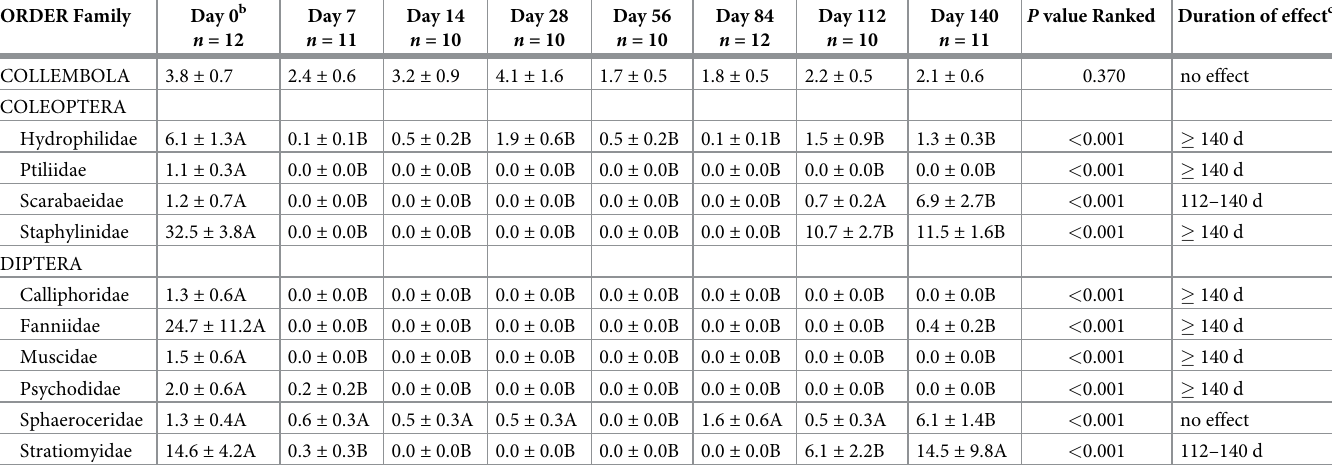
Table 1. Number of insects in each family and Collembola emerging from dung of treated cattle a